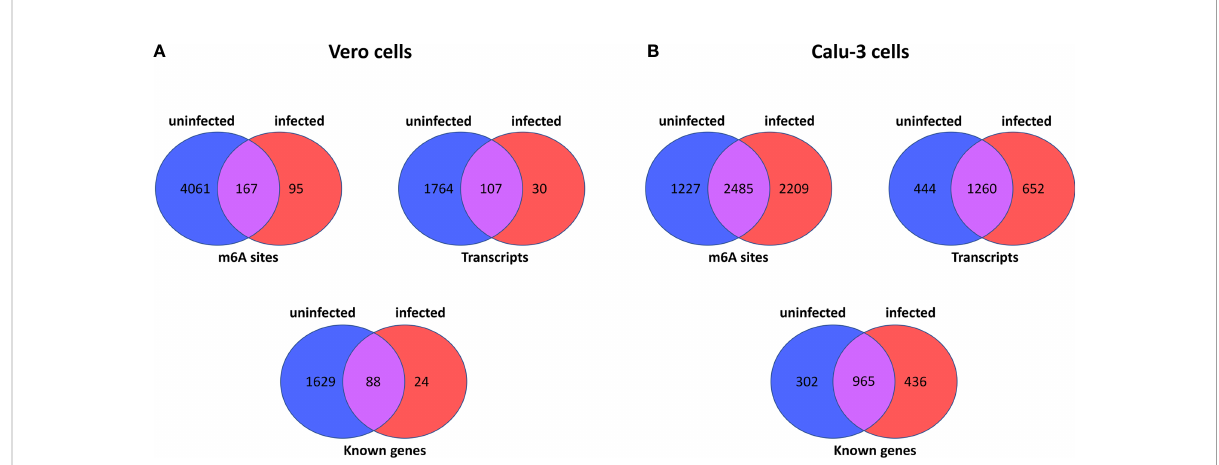
FIGURE 1 Summary of number of m6A sites, number of transcripts and number of known genes in host cell epitranscriptome data here analysed. The Venn diagrams show the number of m6A sites in uninfected and infected Vero cells (derived from African Green Monkeys) (Kim et al., 2020) (A) , and between uninfected and infected Calu-3 cells (human derived) (Chang et al., 2021) (B) . In each panel, the number of m6A sites, transcripts and known genes are displayed for each host cell type.